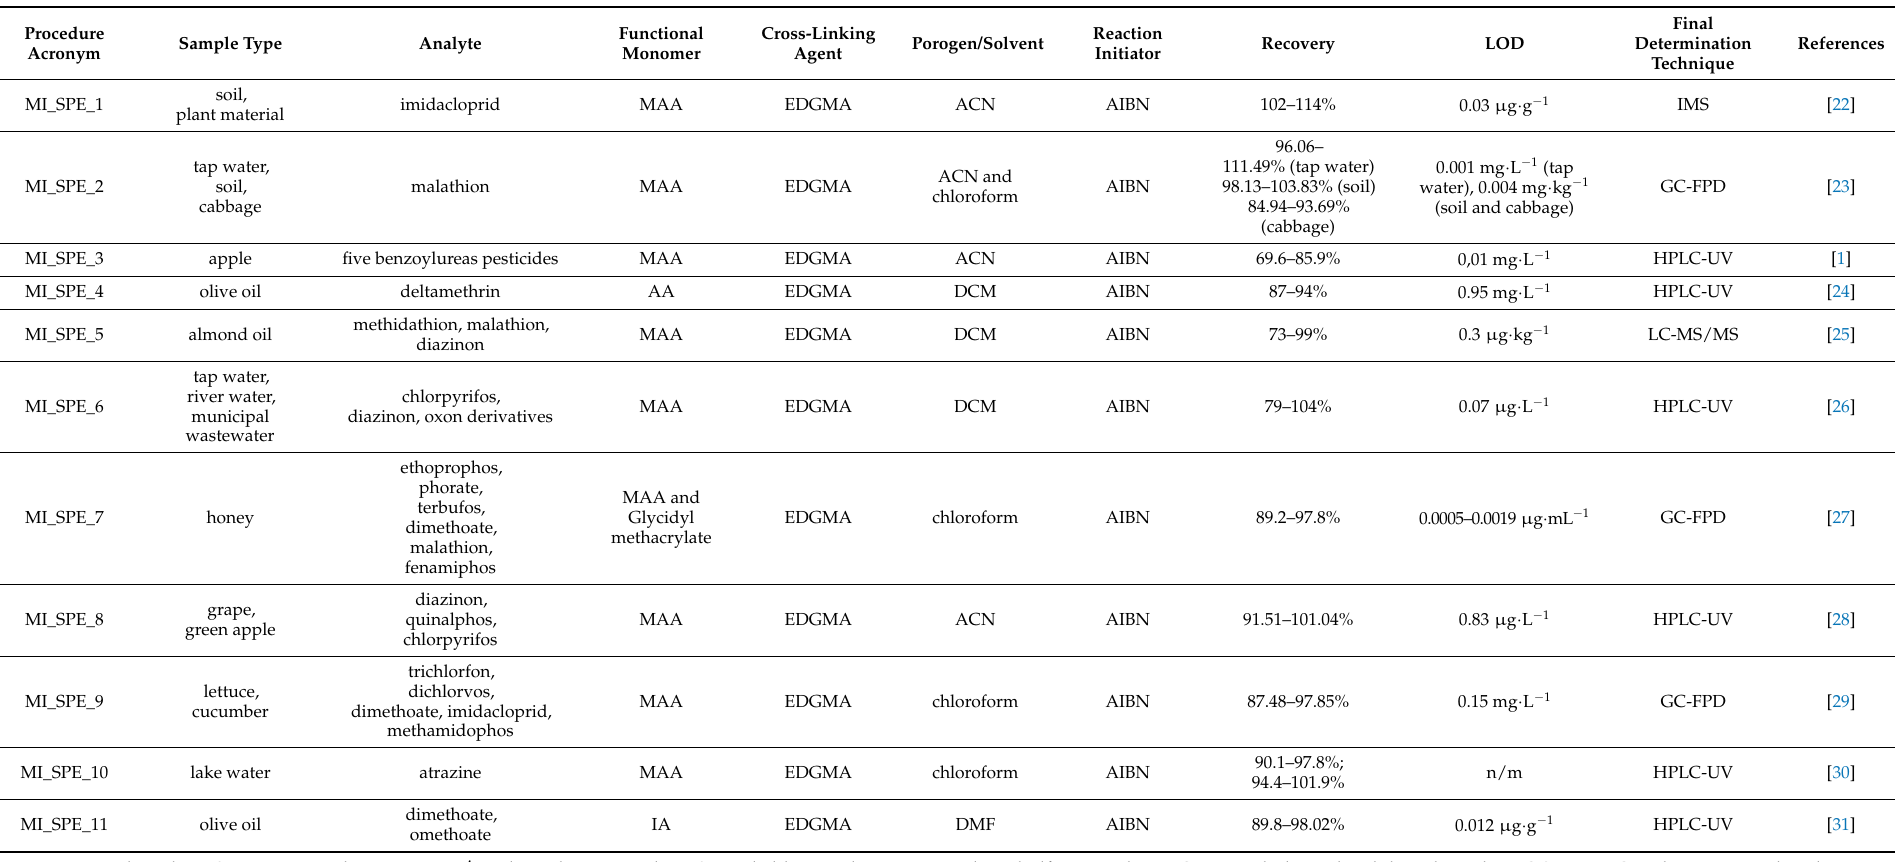
Table 2. Selected examples of application of MI-SPE technique in analytical procedures for the determination of pesticide representatives in environmental and agricultural samples. Procedure